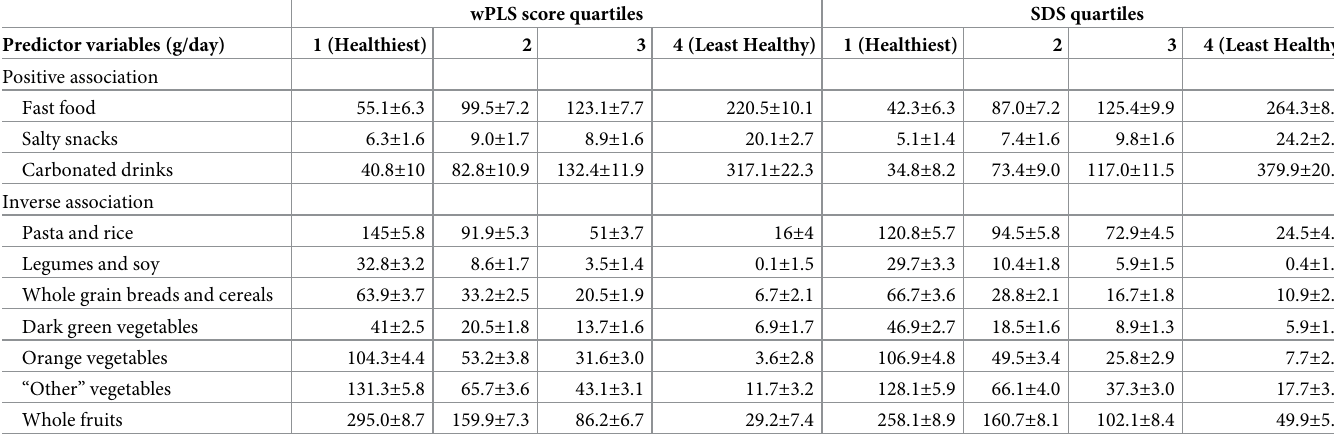
Table 4. Weighted mean daily intake of food predictors 1 which loaded significantly (i.e. loading factor � |0.17|) across quartile categories of energy-dense, high-fat and low-fiber density (“obesogenic”) dietary pattern score generated from wPLS, and the simplified dietary pattern score (SDS) among Canadian adults from CCHS-Nutrition 2015 ( n =